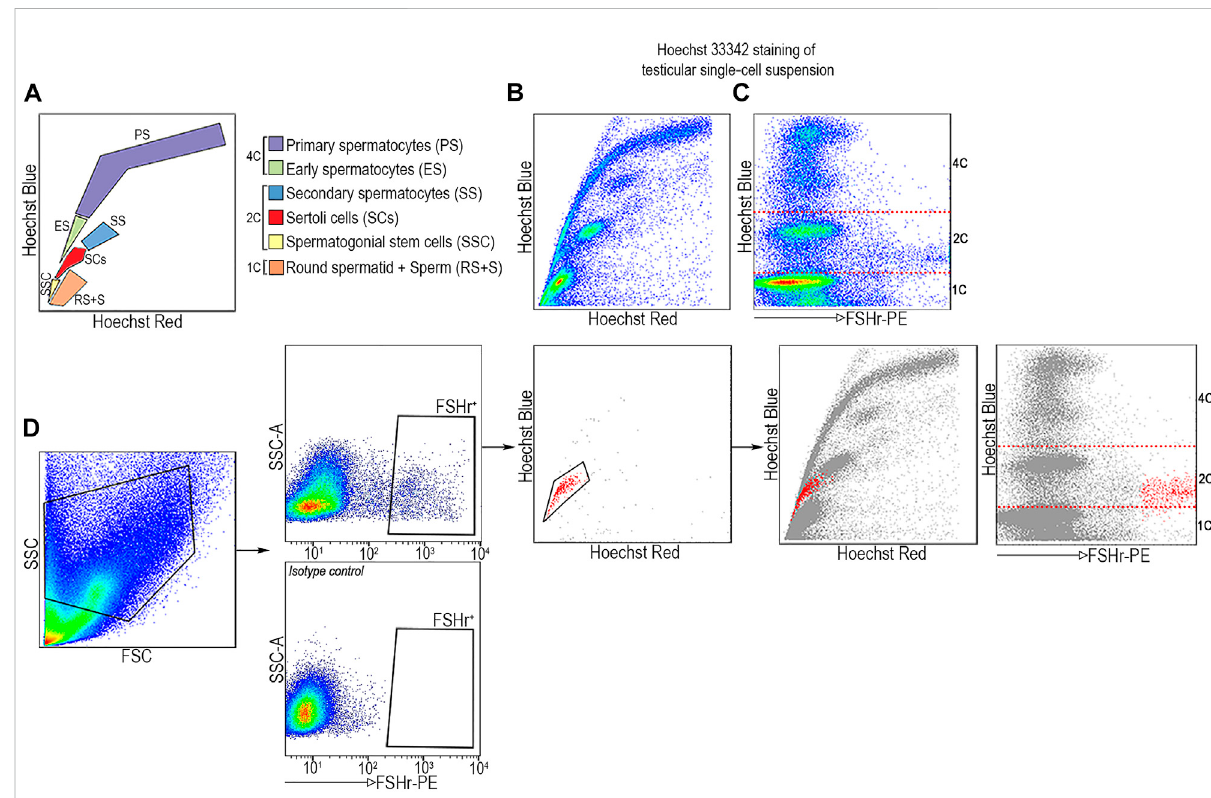
FIGURE 3 FSHr-PE positive cells from STs are found at position corresponding to SCs with 2C DNA content by Hoechst pro fi ling. (A) Scheme of ST- derivedcelltypedistributionafterstainingwithHoechst33342. (B) SinglecellsuspensionfromSTswithFSHr-PEstainingplottedonHoRed/HoBlue pro fi le. (C) FSHr + cellsarefoundintheareacorrespondingto2CDNAcontent(HoBlue)whichisdemarcatedbythedashedline. (D) FSHr + cellswere plottedonHoRed/HoBluepro fi leandbackgatedtototalSTcellpopulations.TheareaswithdistinctcontentofDNA,1,2,and4C,areindicated.